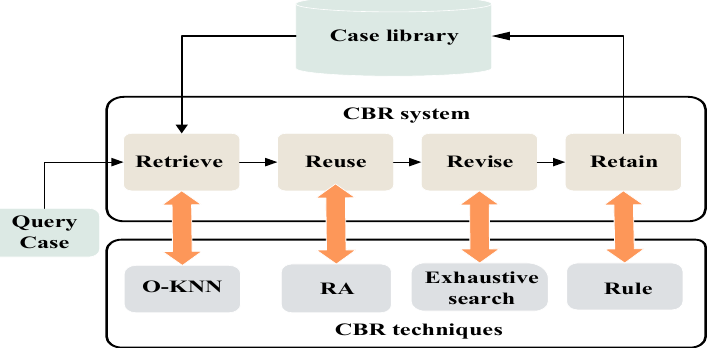
Figure 2. CBR framework.